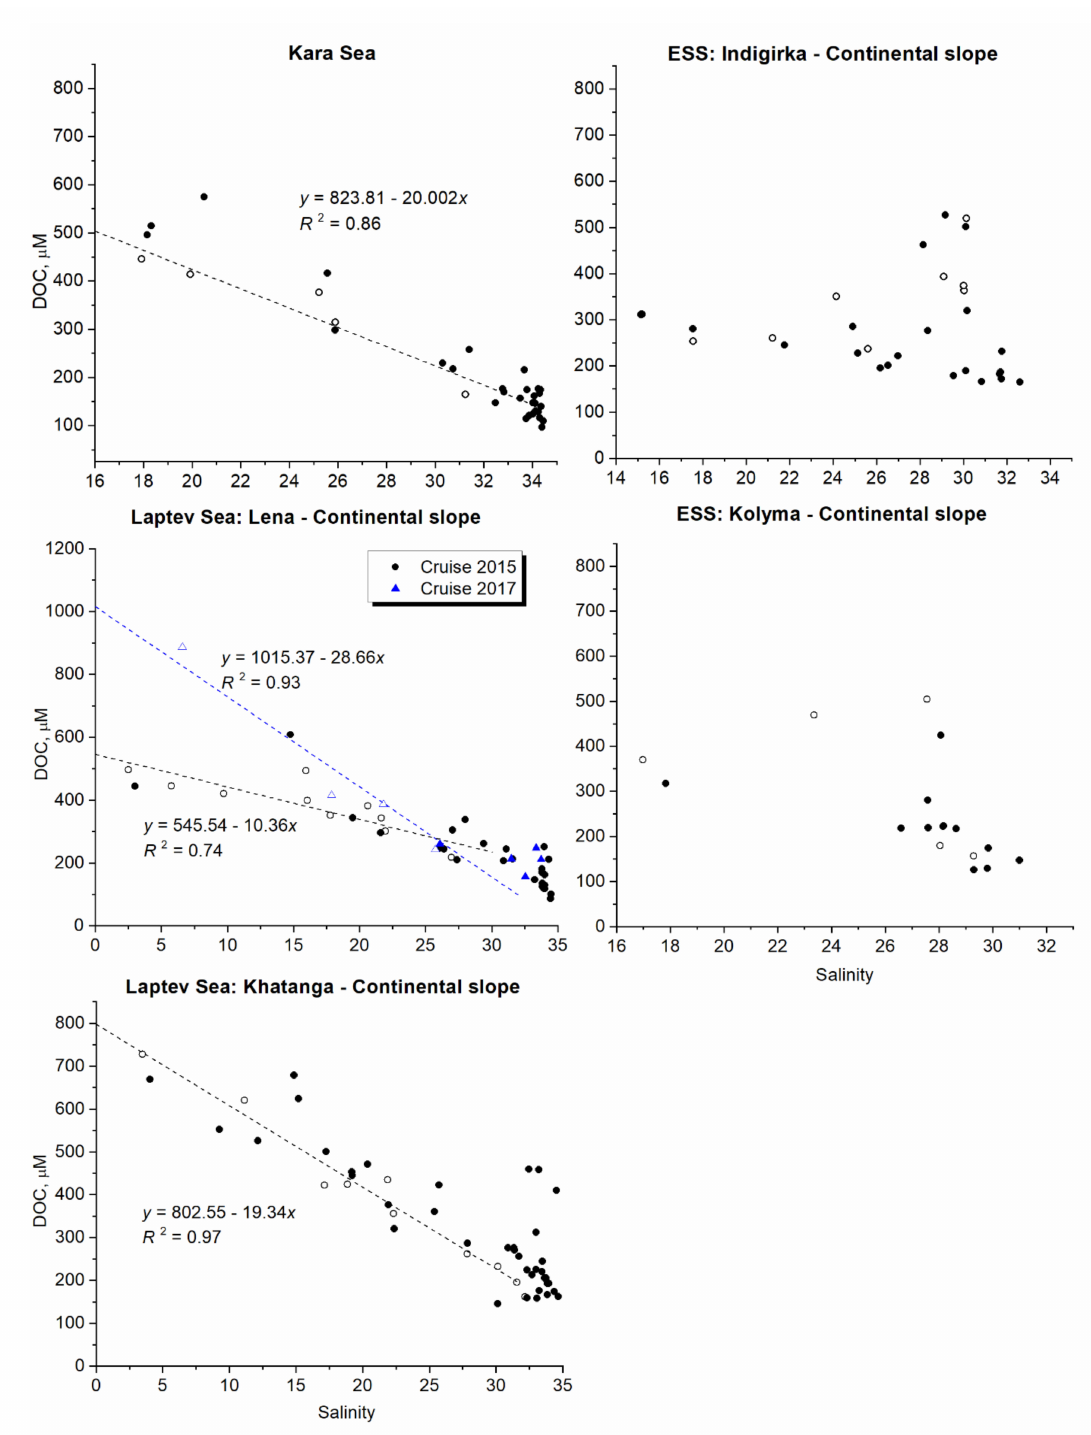
Figure 8. Distribution of DOC along the salinity gradient in the Kara, Laptev, and East Siberian seas. The data on surface and subsurface (1 m depth) waters are shown by open